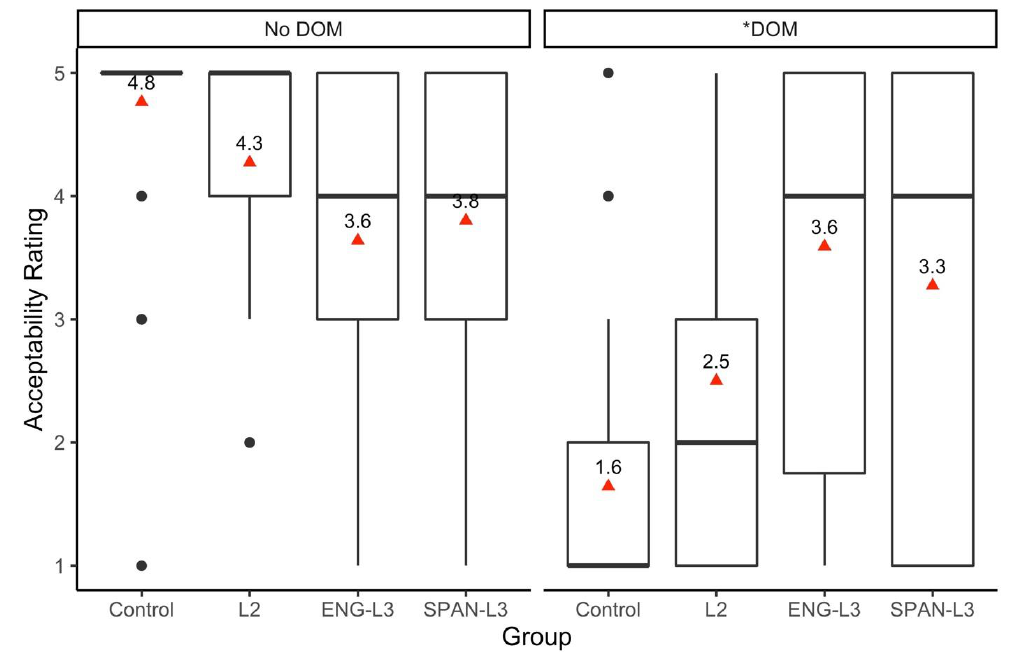
Figure 1 : Mean Acceptability Ratings on Unmarked and Marked Animate Objects (Gallardo & Montrul in